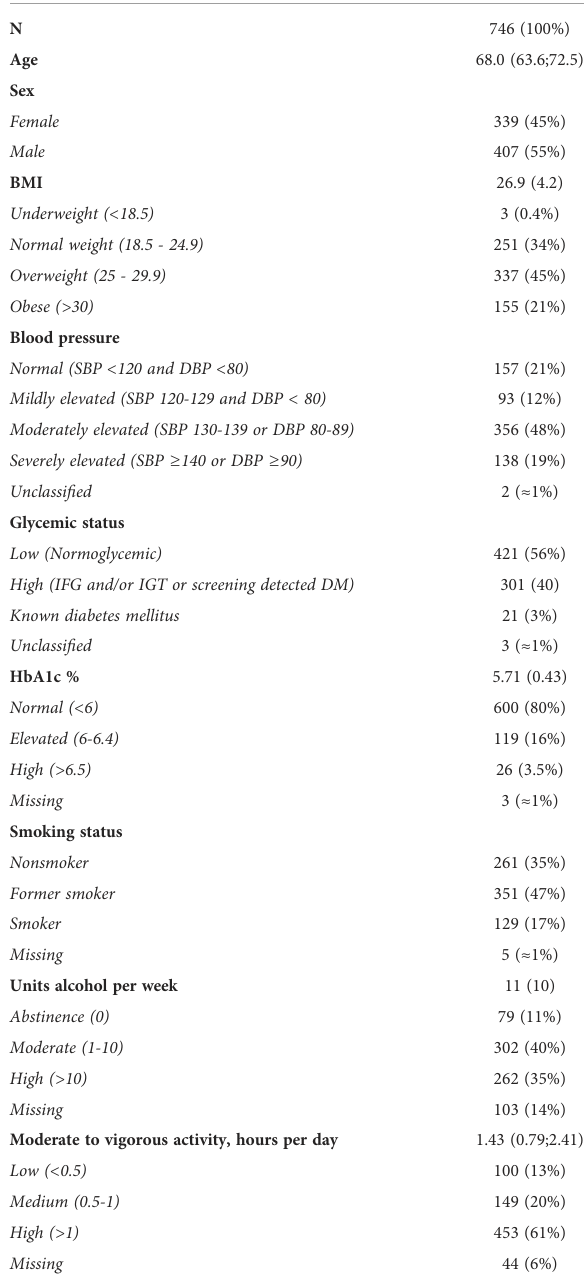
TABLE 1 Population characteristics, N (%) and mean